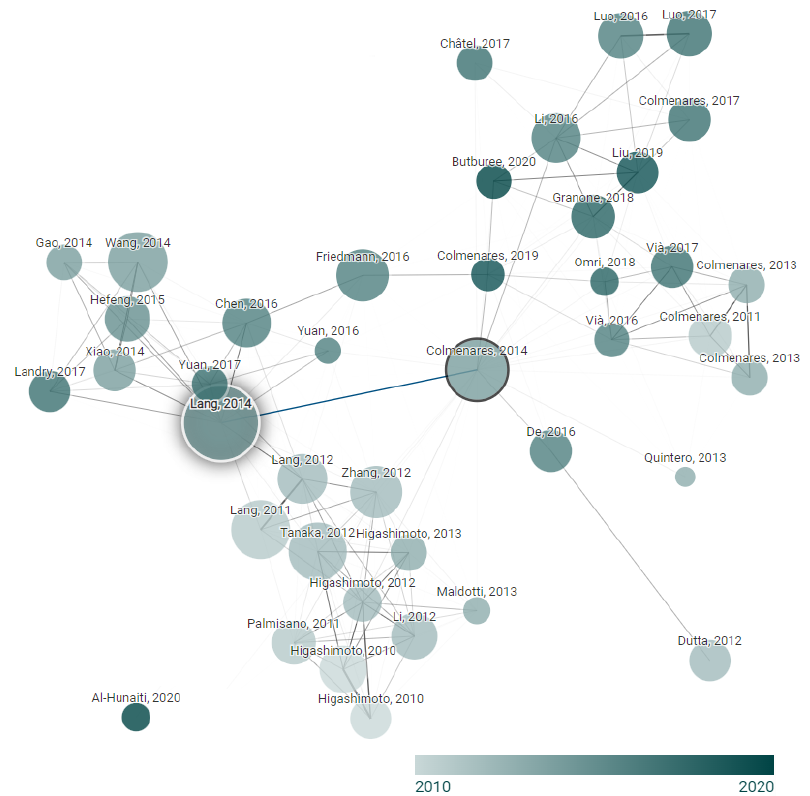
Figure 2. Relevant papers on the field of photocatalysis and biomass in the last decade taken from connected papers .